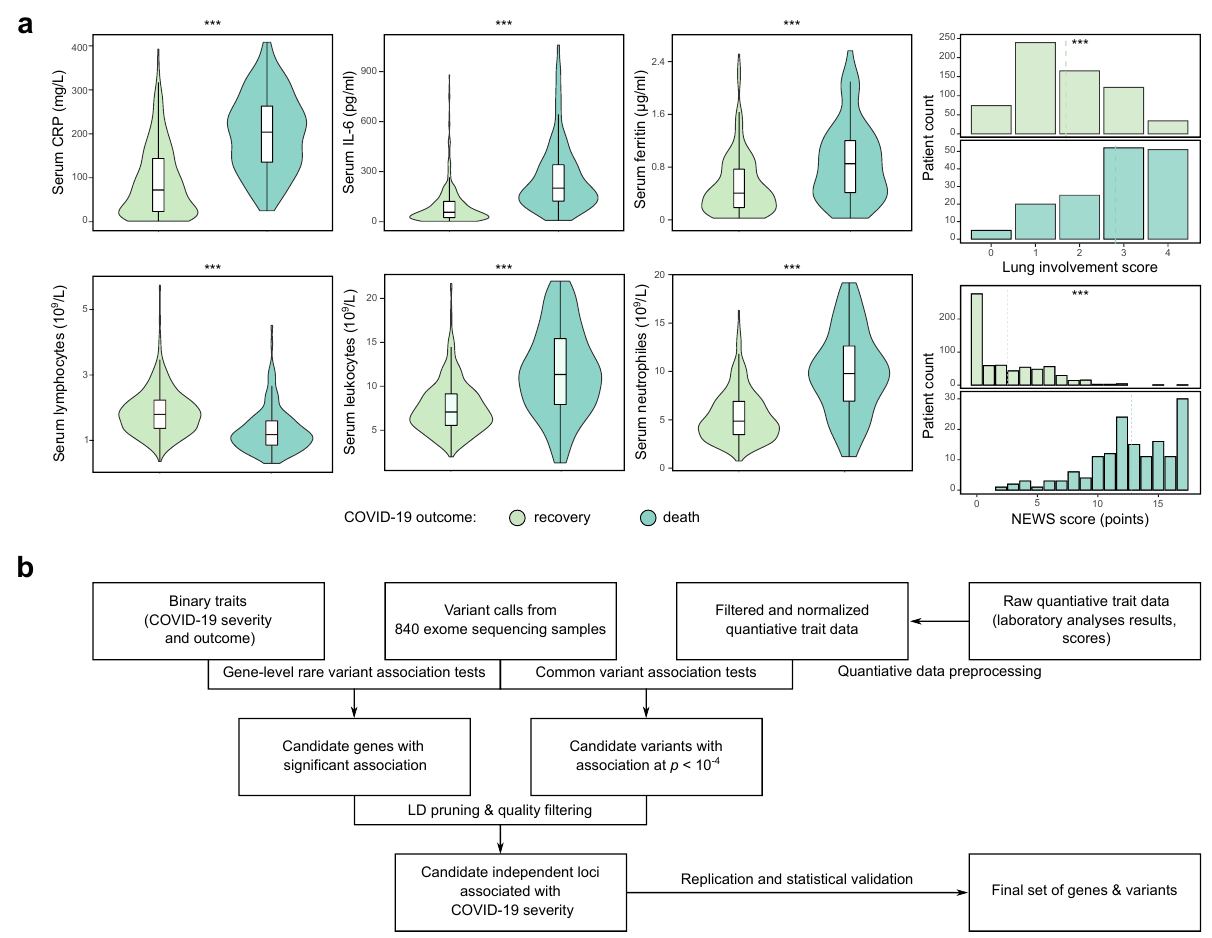
Figure 1. Identification of candidate genetic markers of severe COVID-19 using a deeply phenotype cohort. ( a ) Distributions of selected quantitative traits for individuals with different disease outcome (death or recovery) in the cohort of 840 COVID-19 patients from Russia. Shown are the distributions of the serum C-reactive protein (CRP), interleukin-6, and D-dimer levels, CT-based lung involvement score (ranging from 0 to 4), counts of lymphocytes, leukocytes, and neutrophils in the blood samples, as well as the National Early Warning Score (NEWS). All values shown correspond to maximum values recorded during the course of hospitalization. Values exceeding three standard deviations from the population mean are omitted. ***— p < 0.001 in Wilcoxon-Mann-Whitney test (for quantitative traits) or chi-squared test (for categorical traits). ( b ) A schematic representation of the data analysis pipeline employed in the present